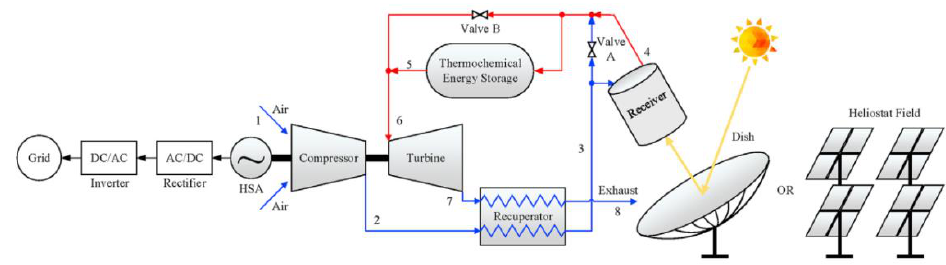
Figure 11. Scheme of the solar-MGT-TCES system [107].